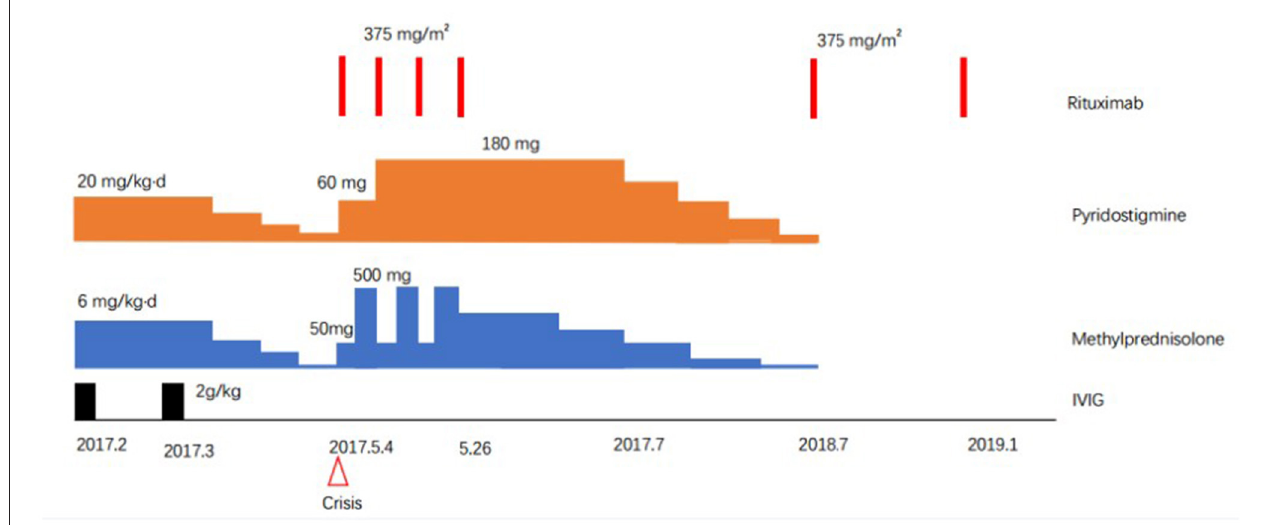
FIGURE 1 | Treatment course of the patient (girl, 13 years old) including Rituximab, methylprednisolone, pyridostigmine, and intravenous immunogloblin